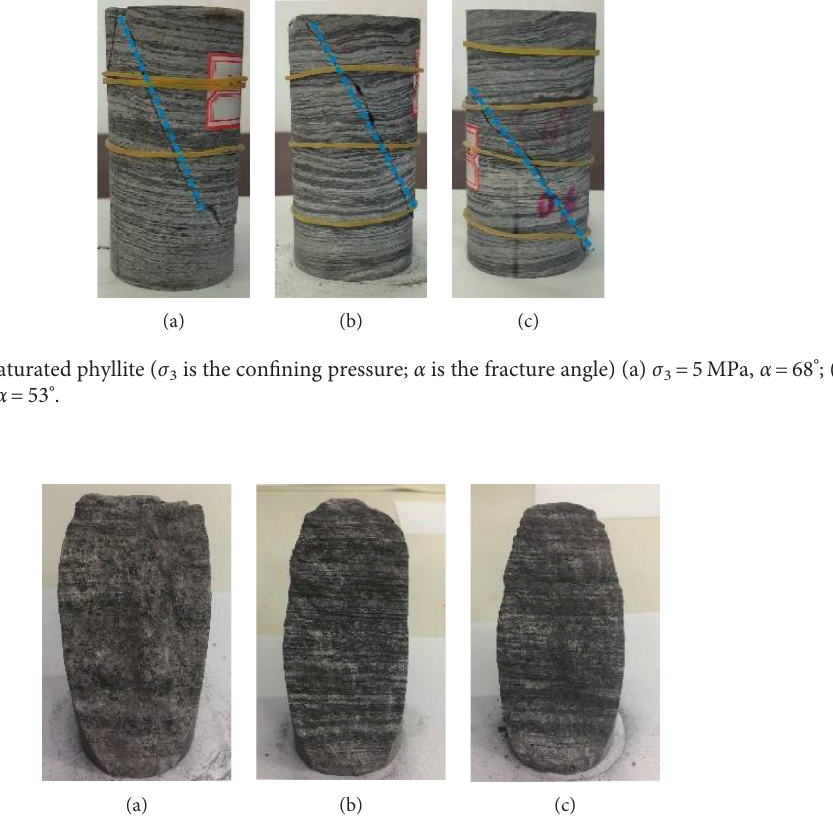
� 5MPa, (b) σ � 10 MPa, and (c) σ � 3 3